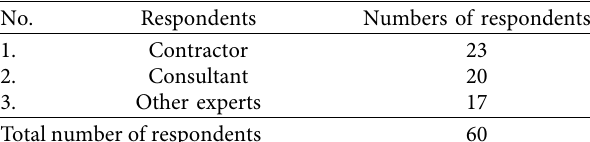
Table 1: Te identifed